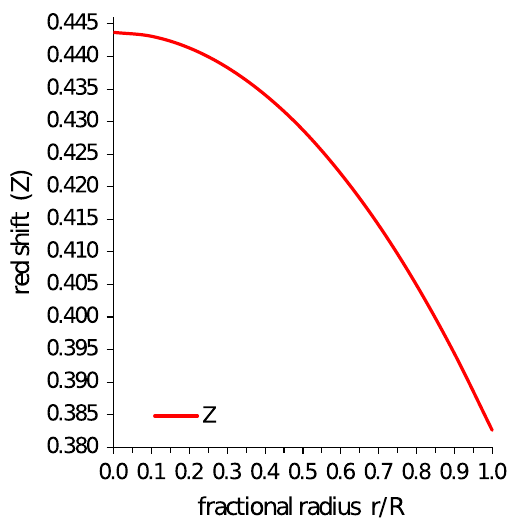
Fig. 12 Anisotropic behavior ( (cid:13) i = (cid:13)/ C ) at the stellar interior with respecttofractionalradialdistance( r / R )for RX J 1856-37.Forplotting